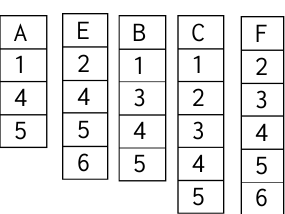
Figure 3. The array structure for storing all